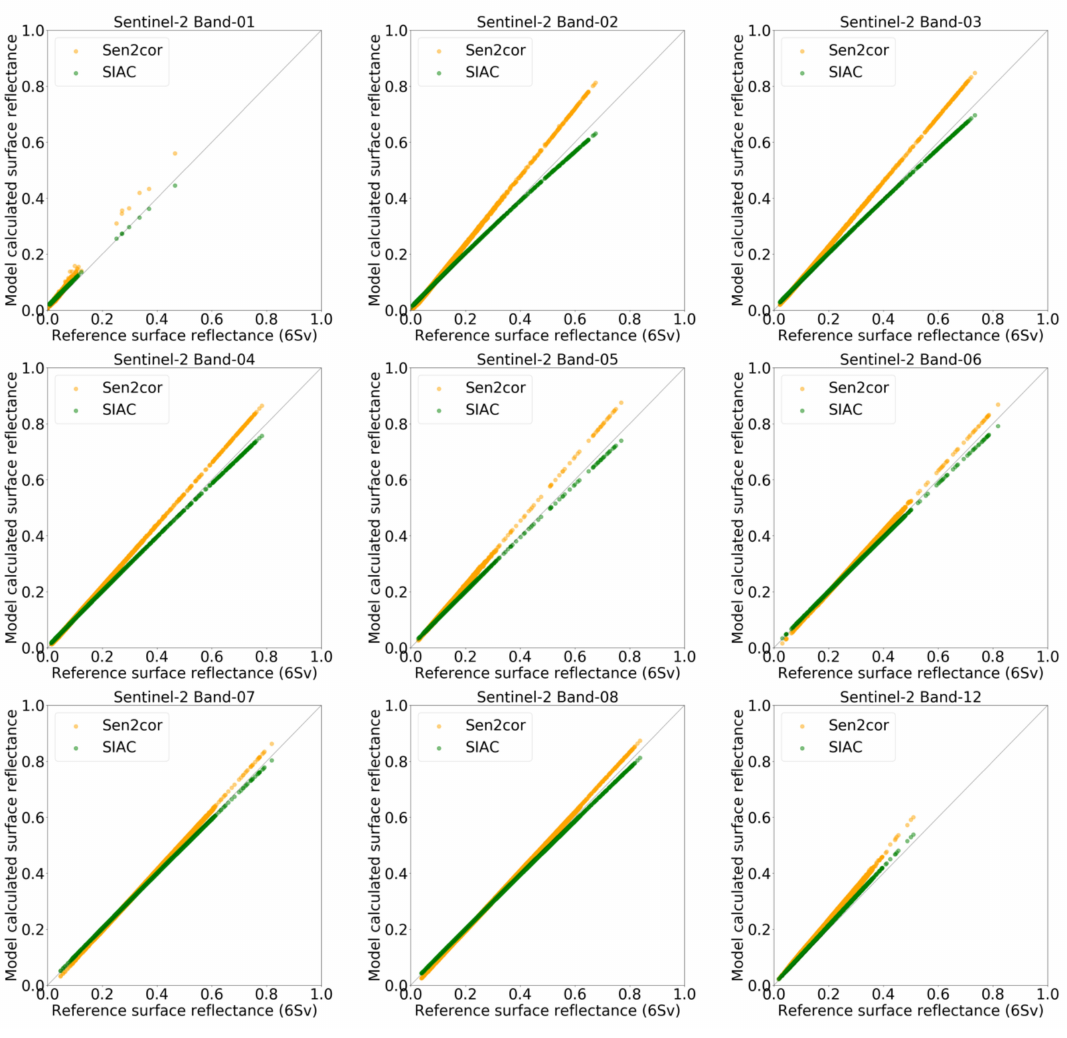
Figure 8. Intercomparison of Sentinel-2 spectral surface reflectance derived from 6Sv, Sen2Cor and SIAC atmospheric corrections at band 1 (442.7 nm), band 2 (492.4 nm), band 3 (559.8 nm), band 4 (664.6 nm), band 5 (704.1 nm) and band 6 (7 40.5 nm), band 7 (782.8 nm), band 8 (832.8 nm) and